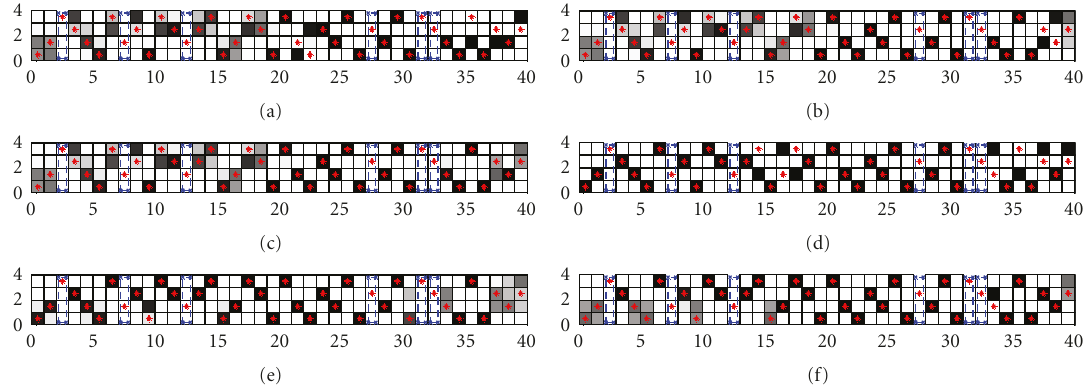
Figure 7: Marginal distribution of labeling variable in exact inference. The 3rd, 8th, 13th, 28th, 32nd, and 33rd observations are missed, depicted as dashed column. The true labels are depicted by stars. Each column represents the marginal distribution of the label of an observation. Grayscale corresponds to probability value. Blacks represent probability 1 and white probability 0. (a) Forward pass with 0- order model. (b) Forward pass with 1-order model. (c) Forward pass with 2-order model. (d) Backward pass with 0-order model. (e) Backward pass with 1-order model. (f) Backward pass with 2-order